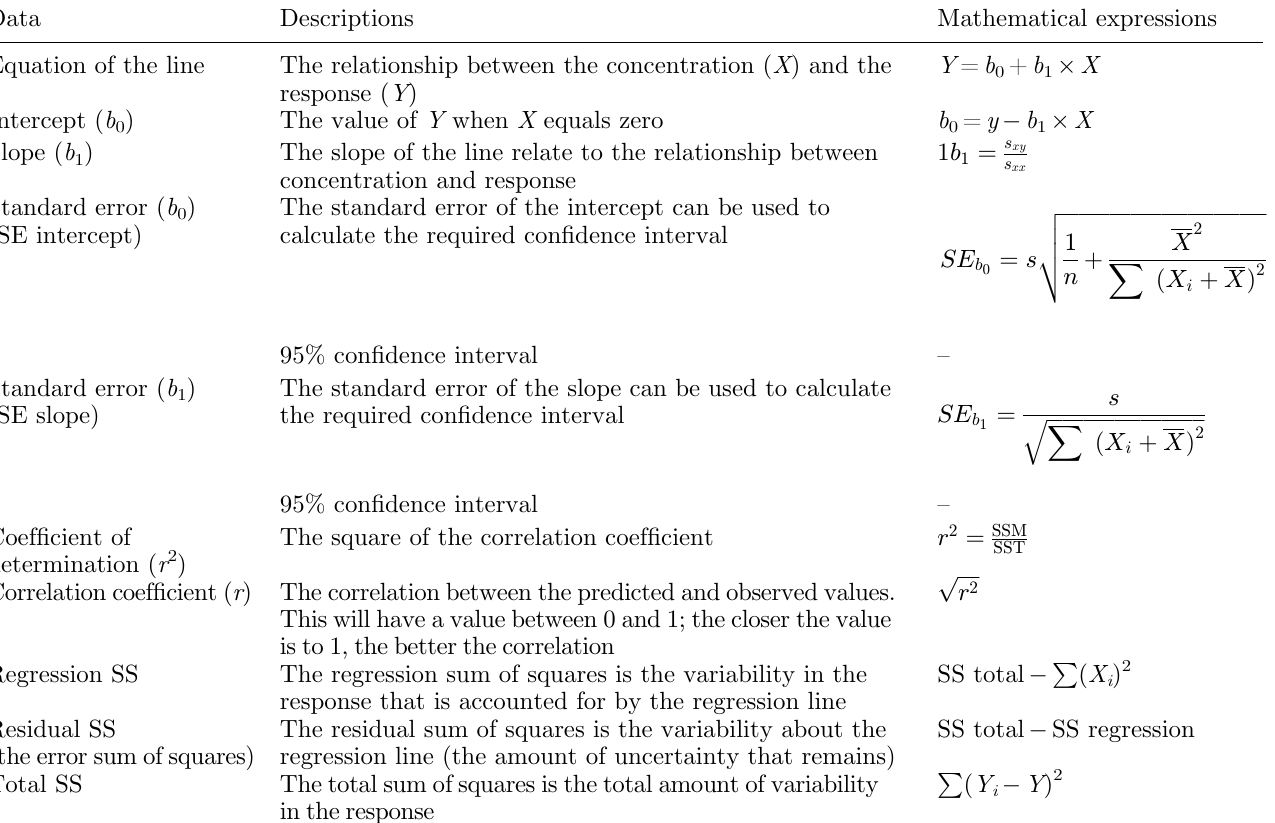
Table 3. Regression